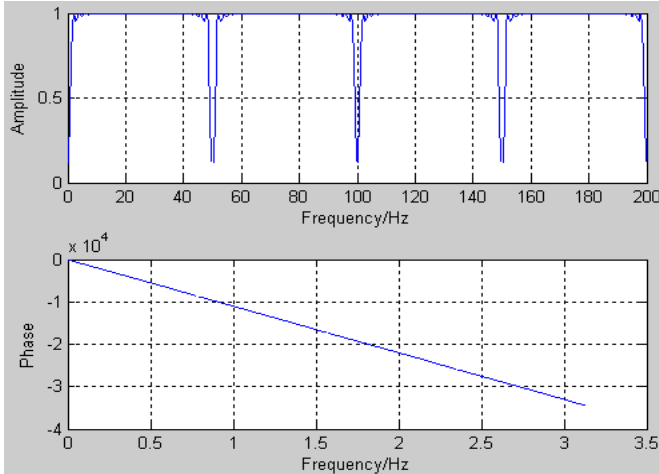
Figure 6. Amplitude-frequency response and phase-frequency response of band-stop filter.